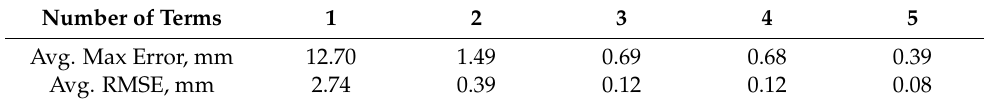
Table 2. The effect of the number of Fourier series fit terms used for fitting the profile data on the maximum and Root-Mean-Square Error (RMSE) averaged between all tested pressures.